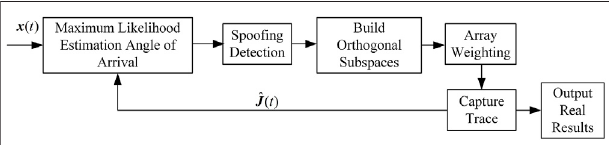
FIGURE 4 | Algorithm processing block